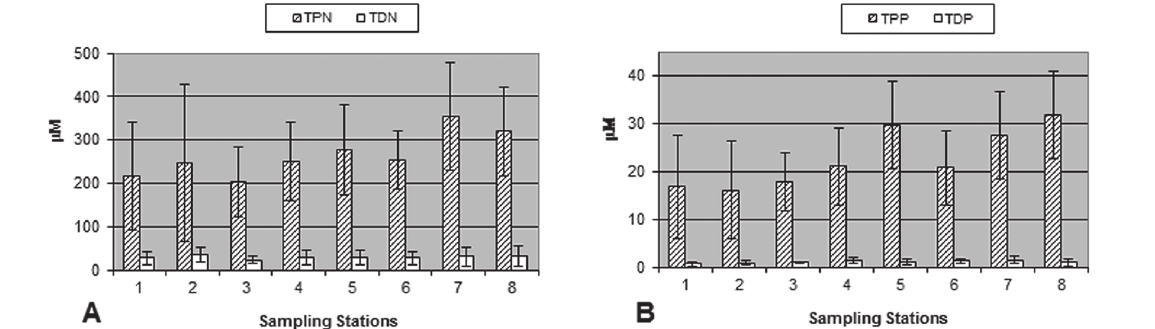
Figure 5 - Mean values and standard deviation of (A) Total particulate and dissolved Nitrogen; (B) Total particulate and dissolved